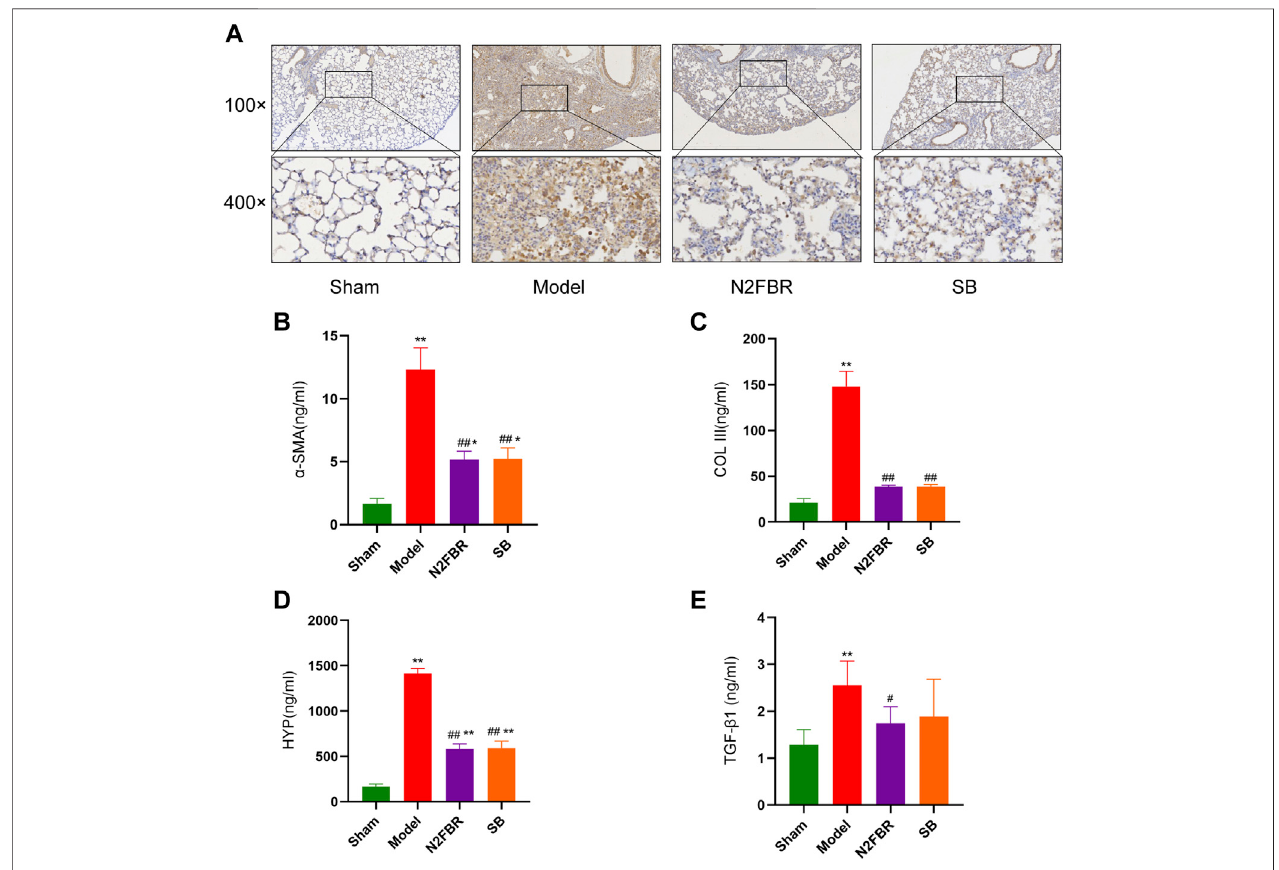
FIGURE3 | Effects of N2FBR on fi brosis related markers. (A) Immunohistochemistry assays for Col I in different groups. (B – E) Total serum levels of α -SMA, Col III, HYP and TGF- β 1. Data are expressed as Mean ± SD: ** p < 0.01, compared with sham group, # p < 0.05, ## p < 0.01, compared with model group.